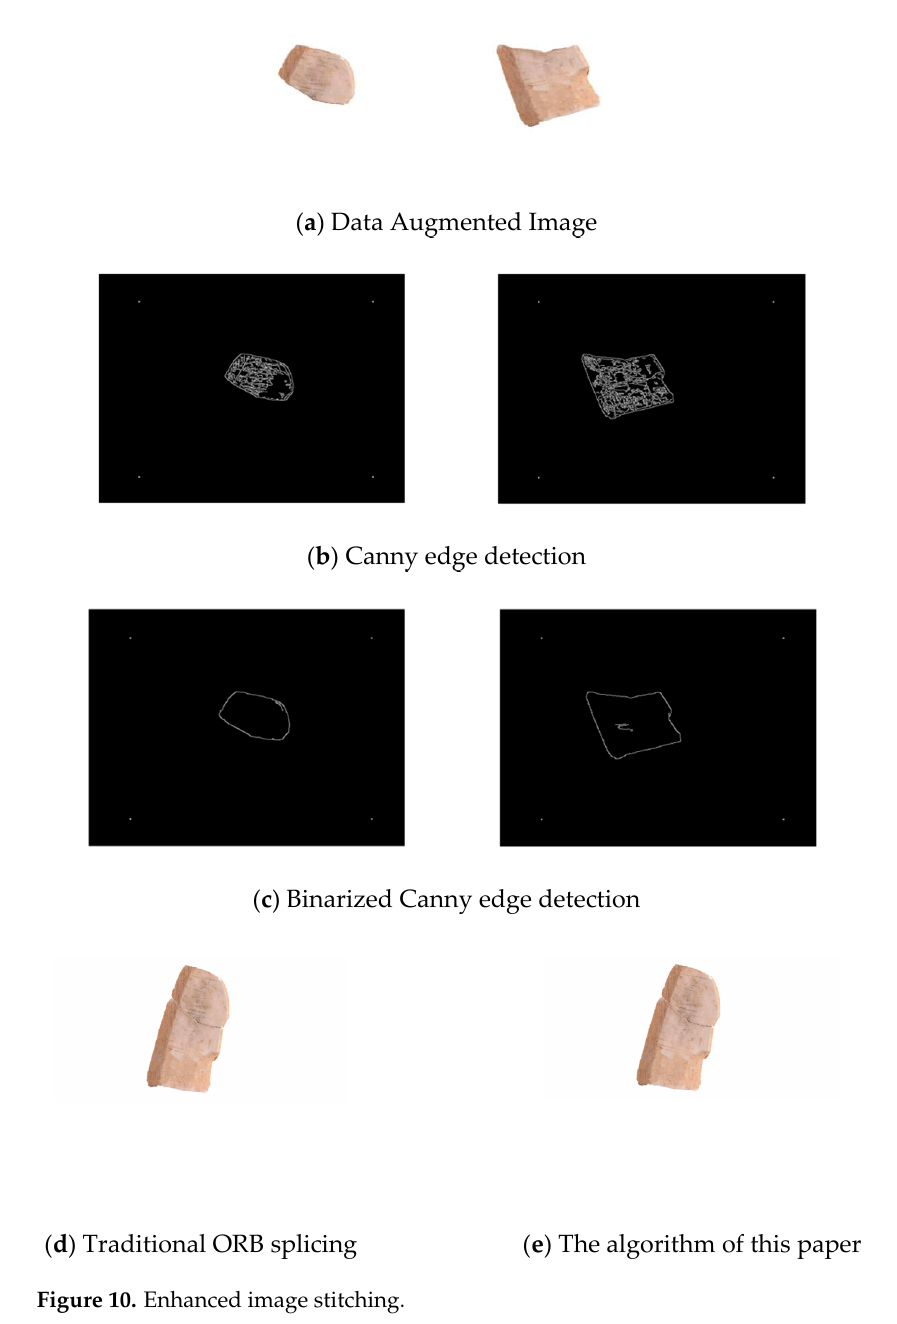
Figure 10. Enhanced image stitching.